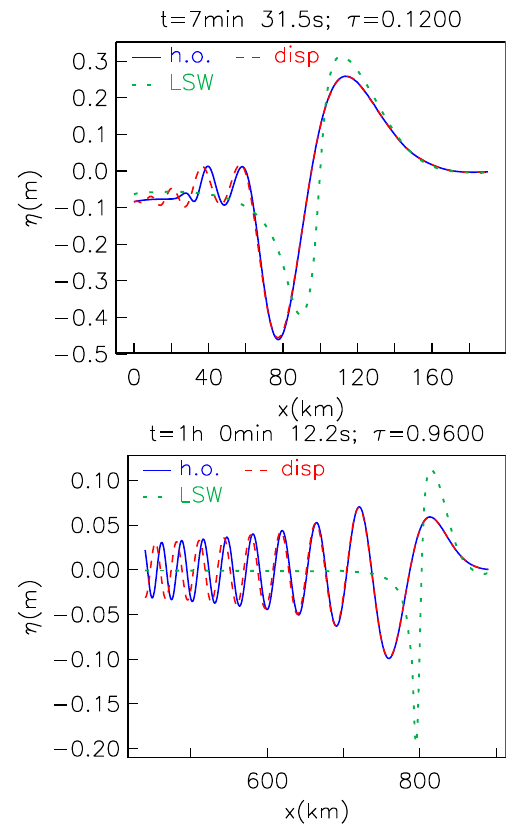
system propagating in the positive x -direction. Results obtained